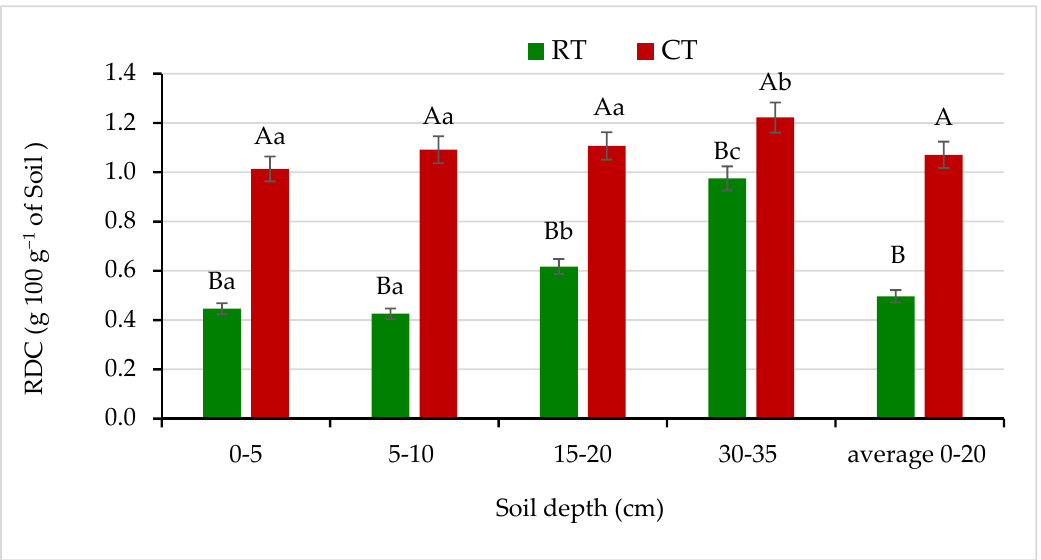
Figure 3. Readily dispersible clay (RDC) content in soil under different tillage systems in 2018–2020 (expressed as means for the 3 years, n = 12). Different letters represent significant differences ( p ≤ 0.05) across treatments according to Tukey’s HSD test; lowercase letters within the same tillage system indicate significant differences between soil depths; uppercase letters indicate differences between tillage systems. RT—reduced tillage system; CT—conventional tillage system; n— number of samples. Vertical bars represent standard errors.